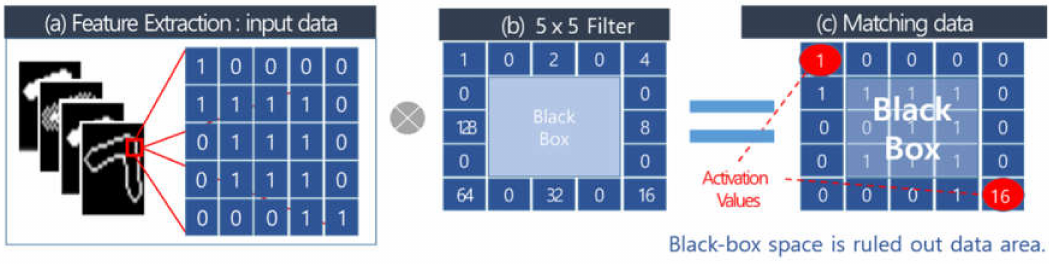
Figure 7. The process of activating the area extraction using the 5 × 5